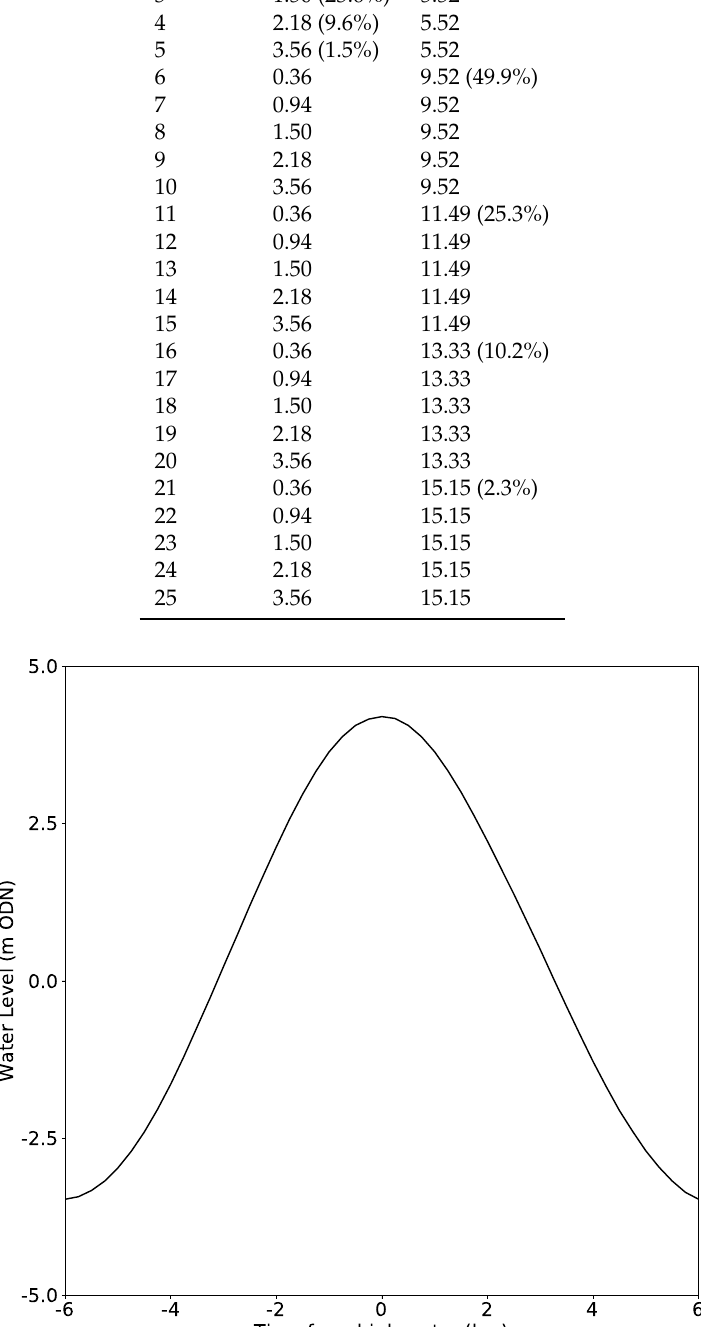
Figure 4. The applied highest astronomical tidal curve, calculated by the POLTIPS3 tidal prediction